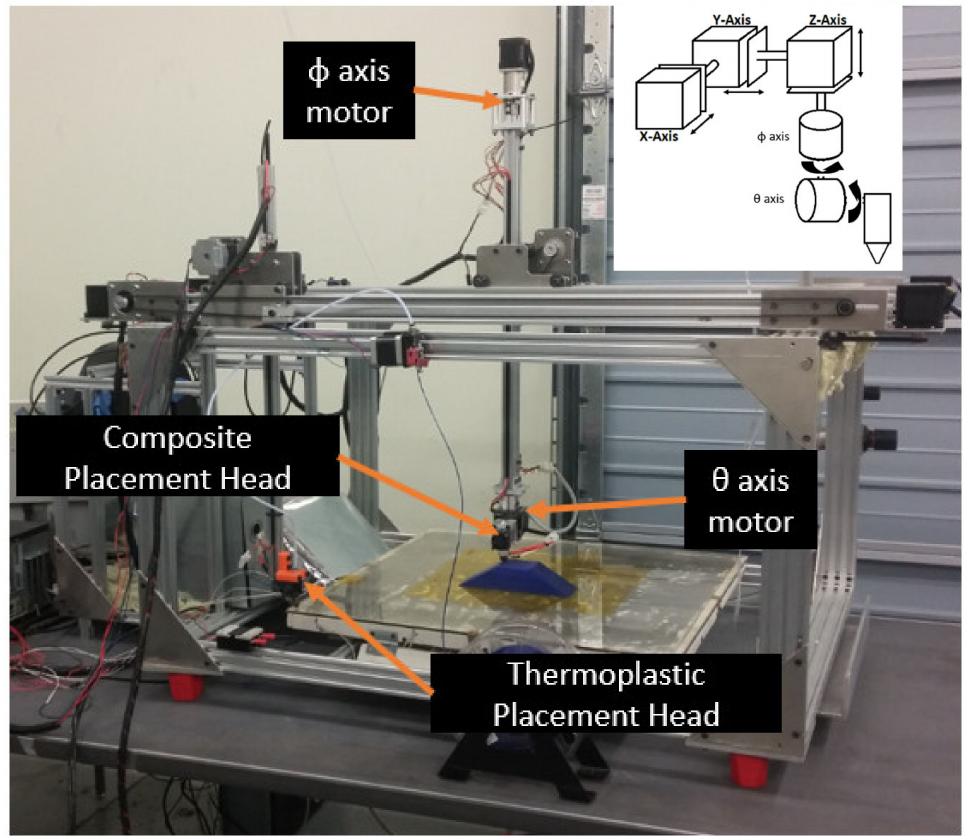
Figure 1. Schematic of the five-axis composite placement